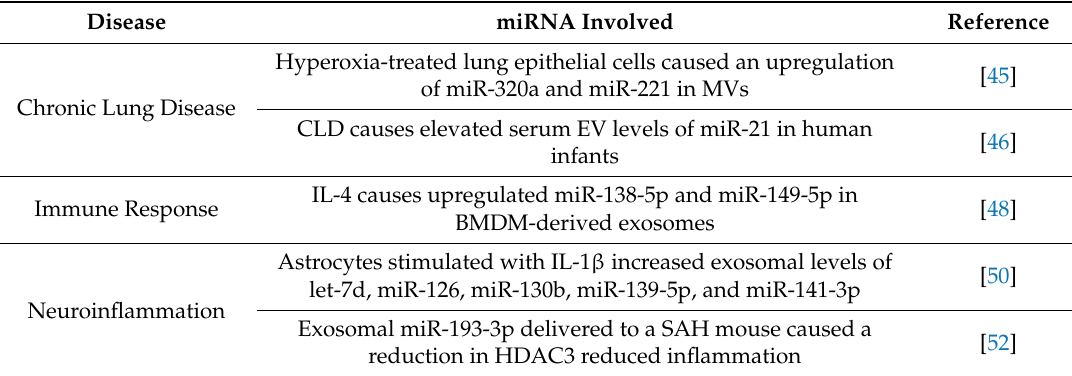
Table 2. List of diseases and the associated e ff ect on EV